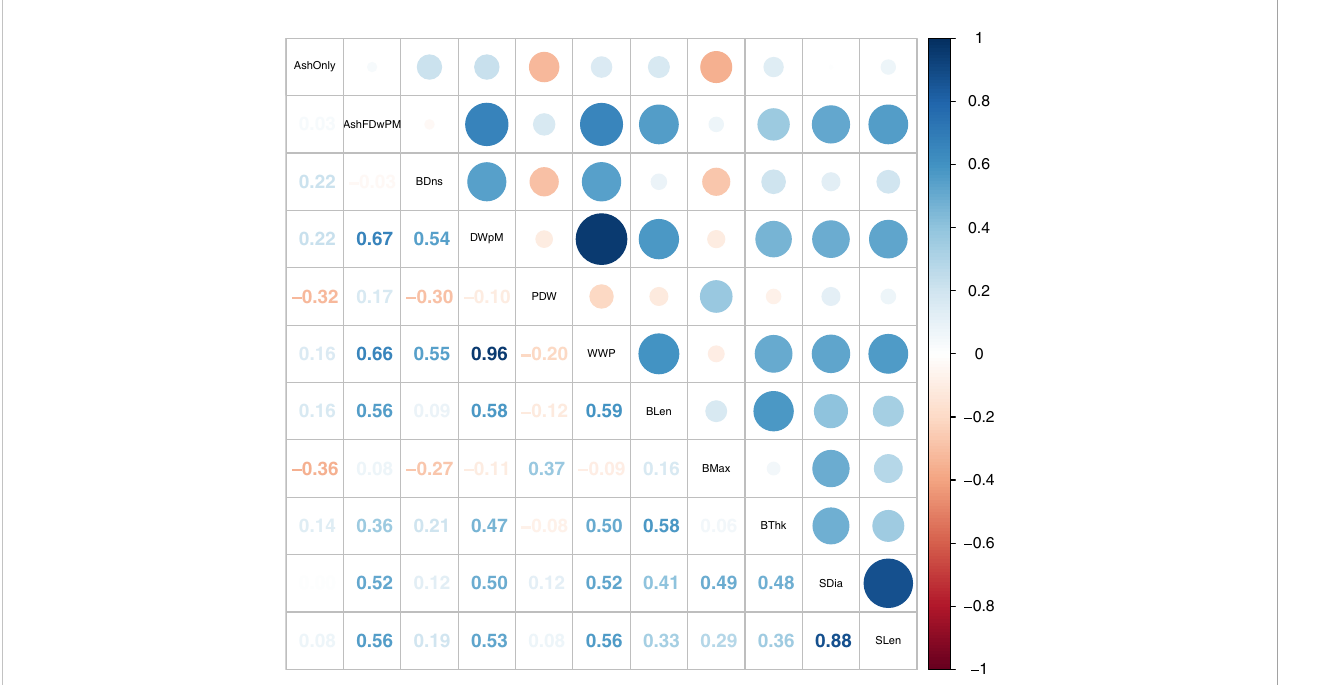
FIGURE 2 Correlation plot of SP breeding values estimated using both Yr2019 and Yr2020 data with the heterogeneous error variance GBLUP model. The combined BVs are the mean of estimates for Yr2019 and